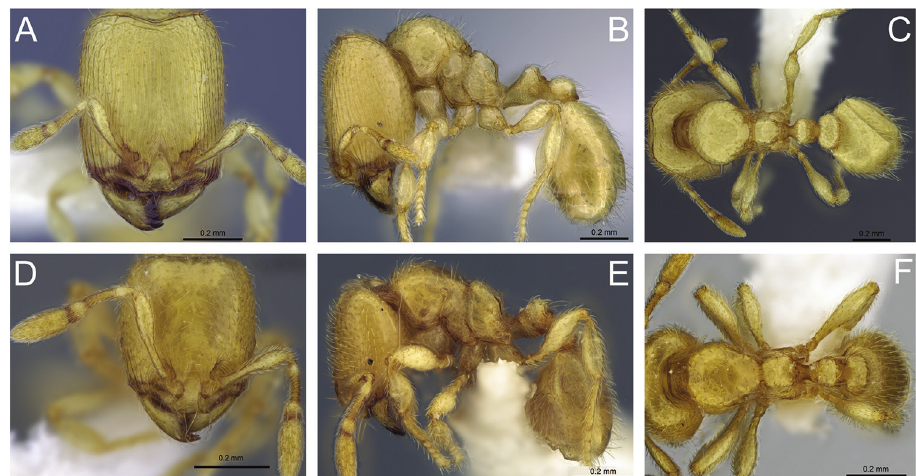
Figure 37. Carebara dota –holotype. Major worker, CASENT0192623. A head in full-face view B body in profile view C body in dorsal view. Minor worker, CASENT0192570 D head in full-face view E body in profile view F body in dorsal